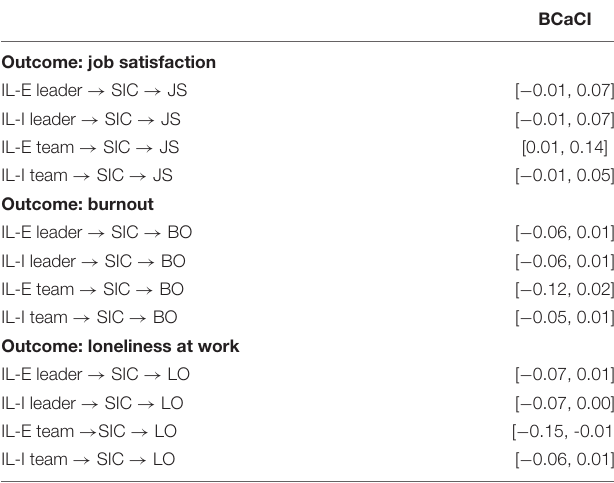
TABLE 4 | Standardized indirect effects of identity entrepreneurship and impresarioship (leader/team) on outcomes at work via social identity